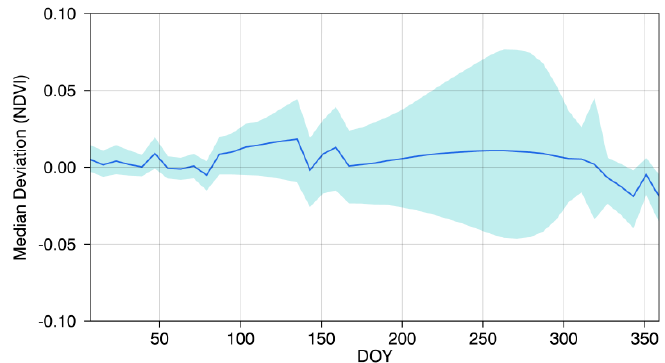
Figure 11. Median deviation of NDVI (blue line) and 1st to 3rd quartile (light-blue area) between ESTARFM predictions for the overlapping areas of path 195 and path 194 for the year 2014.